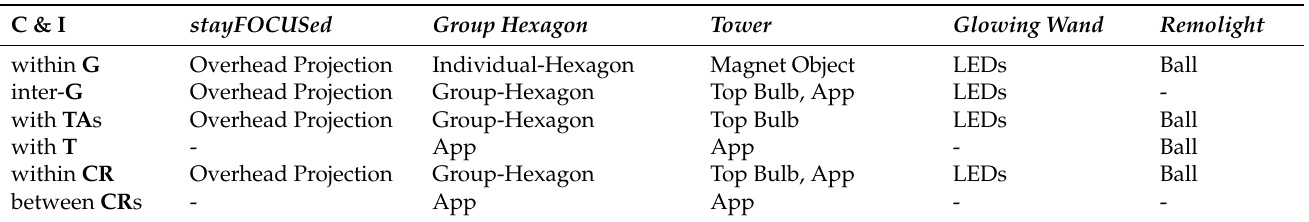
Table 2. Communication and interaction ( C and I ) designs in our paper ( G : Group; TA : Teaching